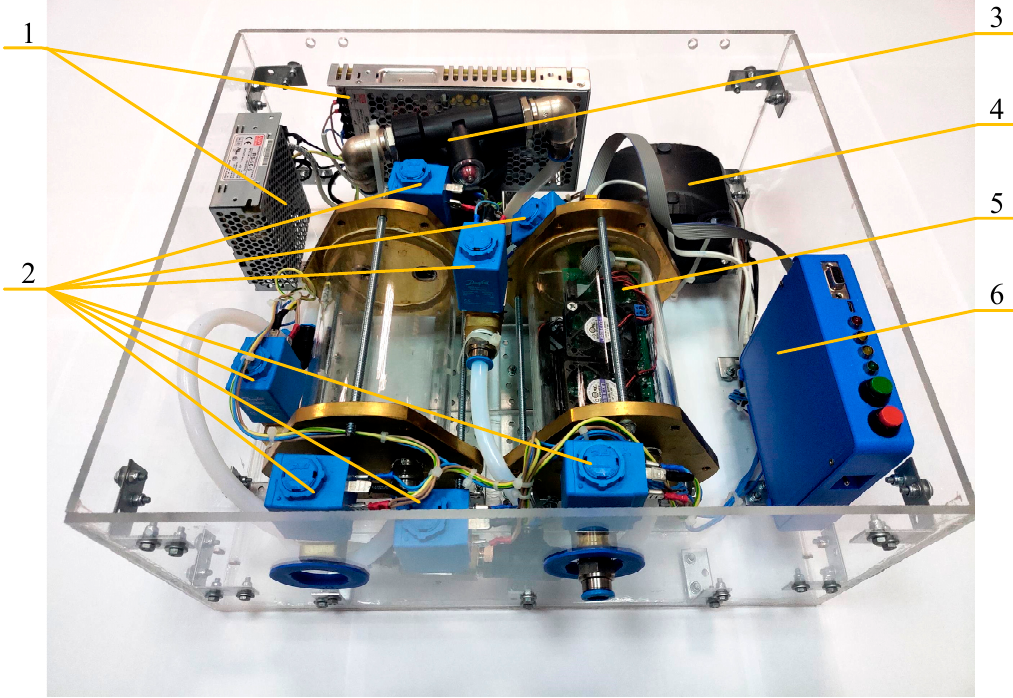
Figure 1. View of the sampling device as part of the gas analytical system.